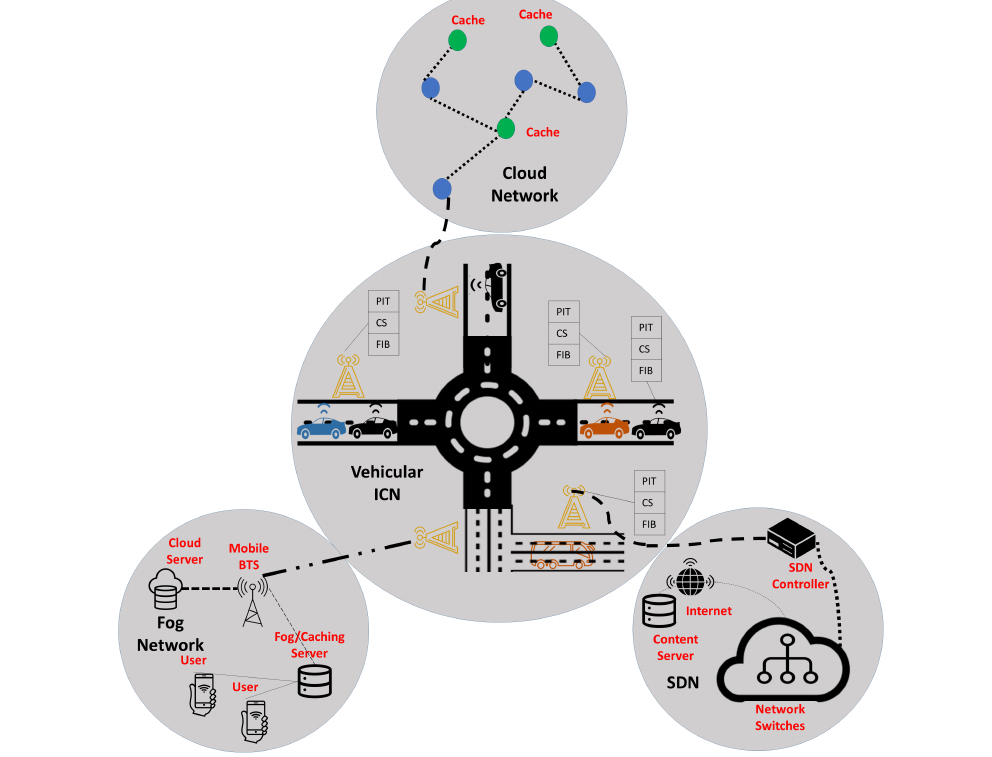
Figure 2. Integration of other technologies with Vehicular